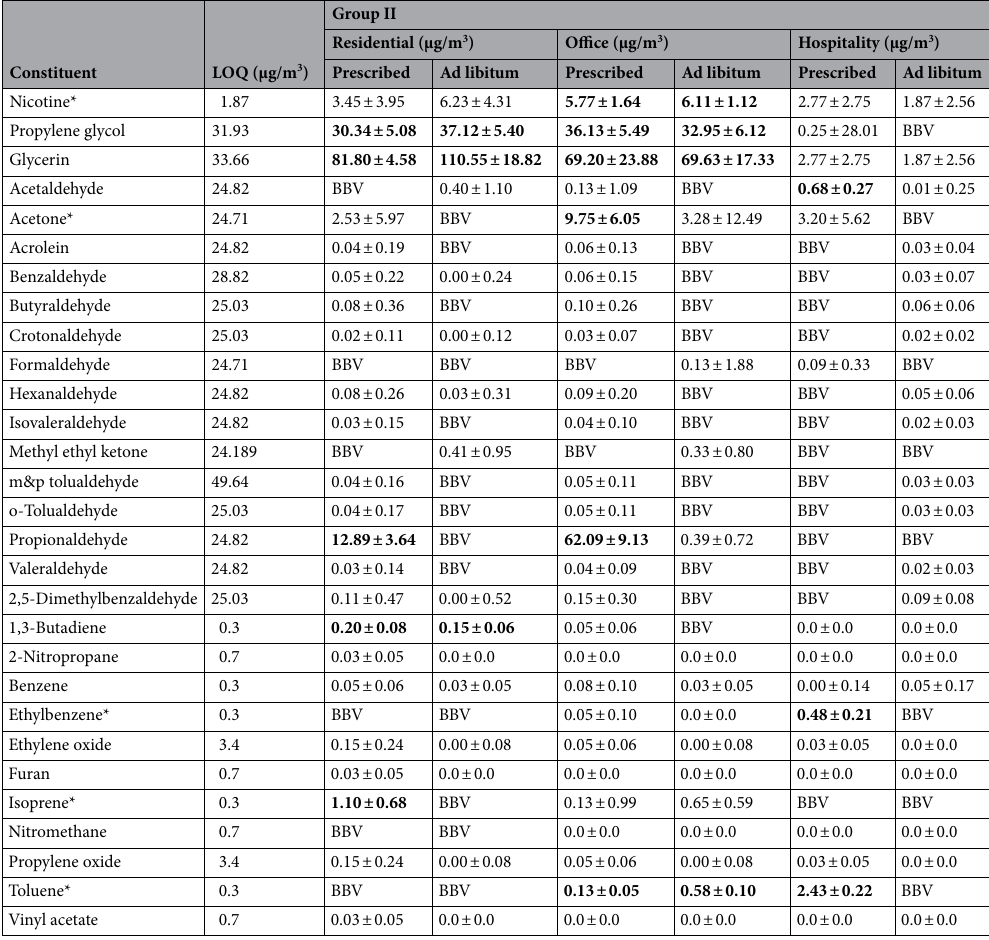
Table 4. Mean (± SD; N = 4) cumulative (4-h) constituent concentrations changes from baseline values for Group II for any constituent detected above LOQ for at least one puffing regimen for any group. Statistically significant constituent values from baseline (p < 0.05) are in bold. Statistically significant differences (p < 0.05) found in baseline concentrations (N = 4) between ventilation conditions are denoted with an asterisk. BBV Below baseline value, LOQ Limit of Quantification is based upon the amount of air sampled and is a composite average from all 4 air samplers used in the six